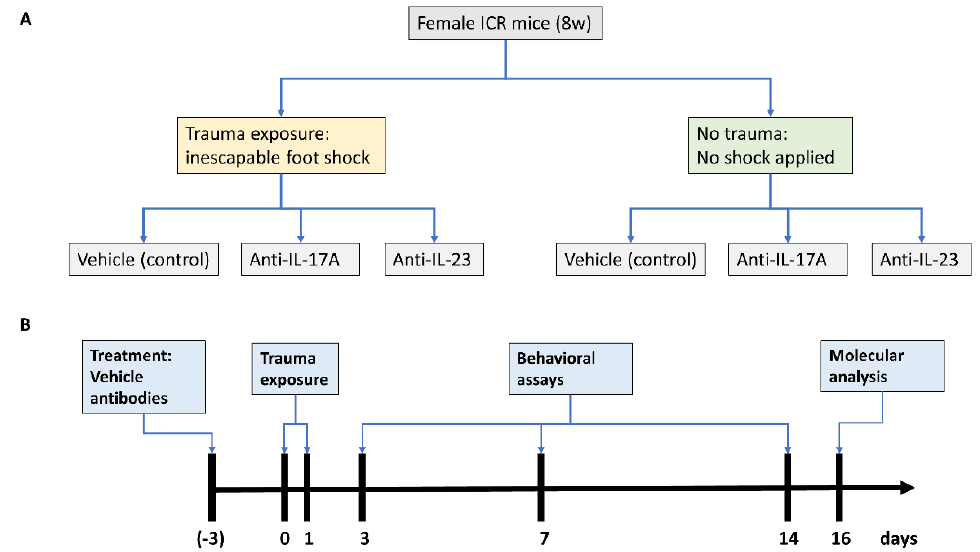
Figure 1. Experimental design. A scheme presenting all experimental groups ( A ) and experimental timeline ( B ).